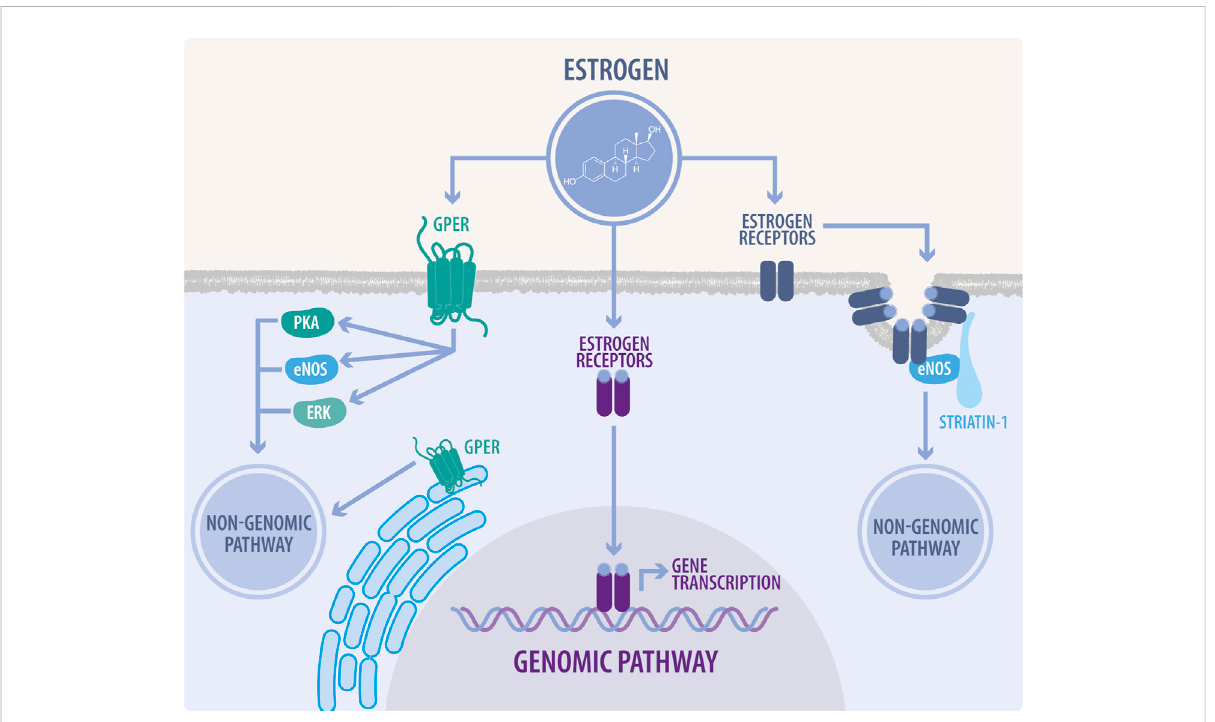
FIGURE 1 Genomic and non-genomic estrogen signaling. In the genomic pathway, estrogens diffuse across the plasma membrane and bind to estrogen receptors (ER). ERs heterodimerize and translocate to the nucleus, inducing the transcription of estrogen response element-associated genes. The non-genomic pathway is characterized by a rapid response, which modulates cellular enzyme activity and thus, directly affects cell function. In this pathway, estrogens bind to ERs associated to caveolae, mainly modulating endothelial nitric oxide synthase (eNOS) activity. They also can bind to G-protein coupled estrogen receptor (GPER) located at the plasma membrane or endoplasmic reticulum, to regulate signaling through eNOS, protein kinase A (PKA), and extracellular signal-regulated kinases (ERK), also known as mitogen-activated protein kinases